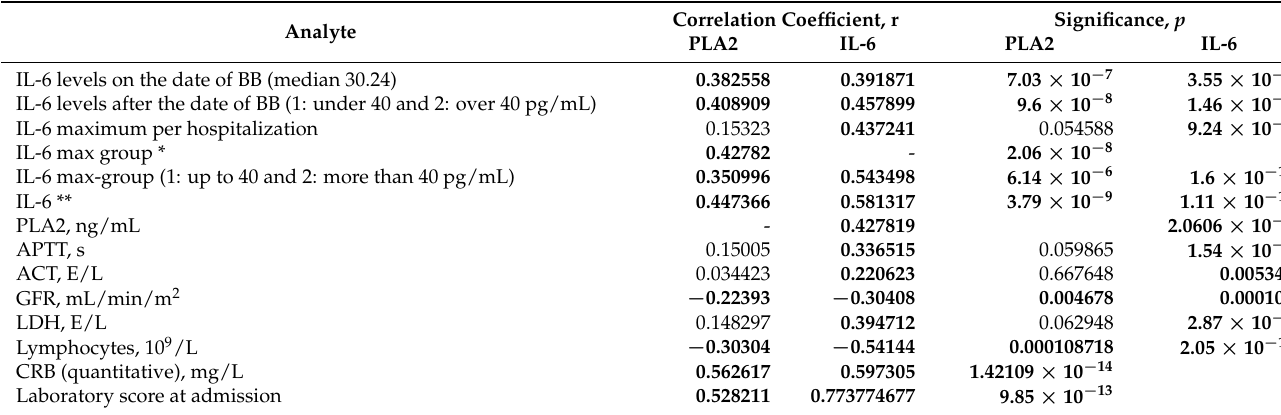
Table 5. PLA2 and IL-6 correlation coefficients with biochemical parameters.